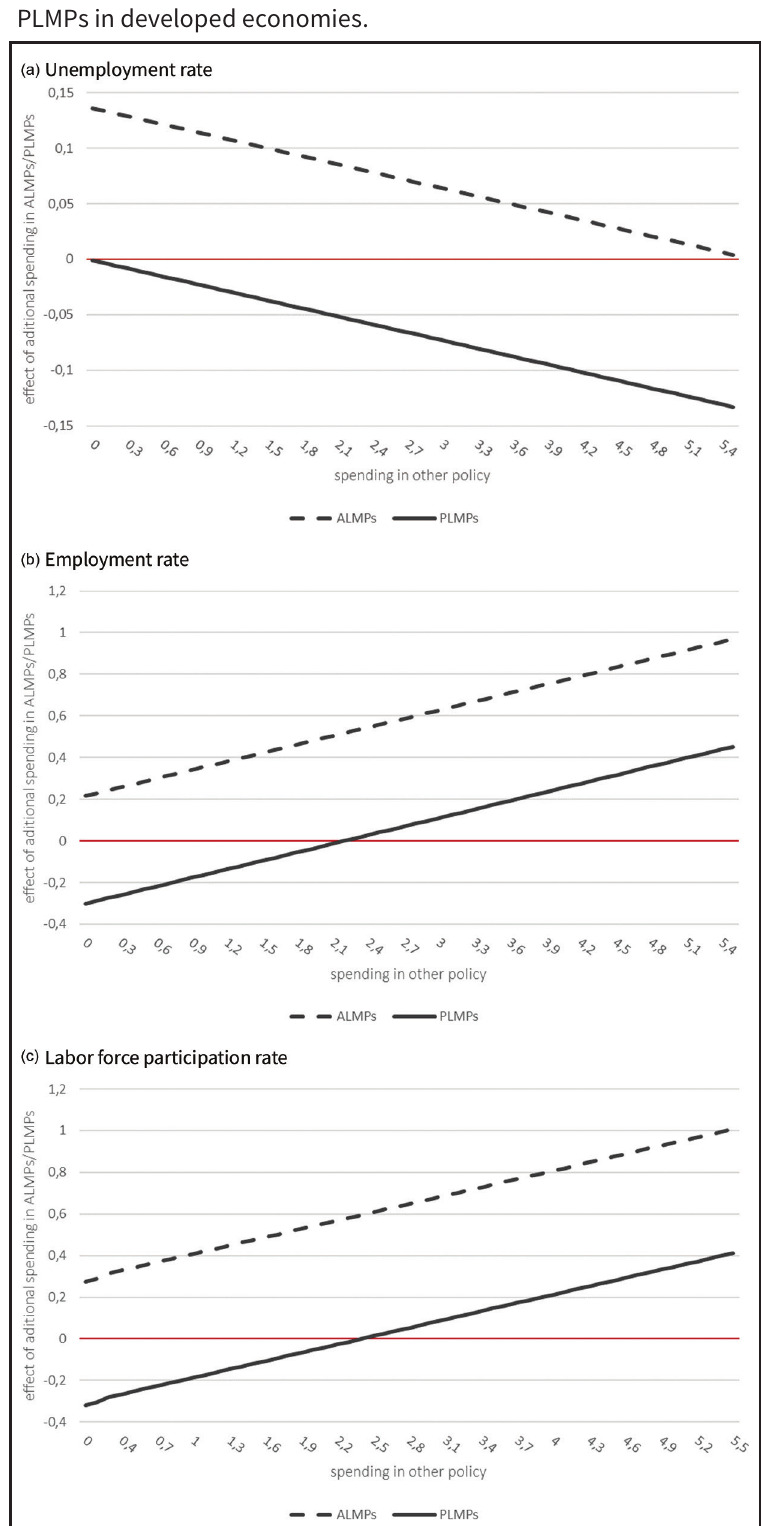
Figure 4. The effect of one additional unit spending on ALMPs (PLMPs) given spending on PLMPs in developed